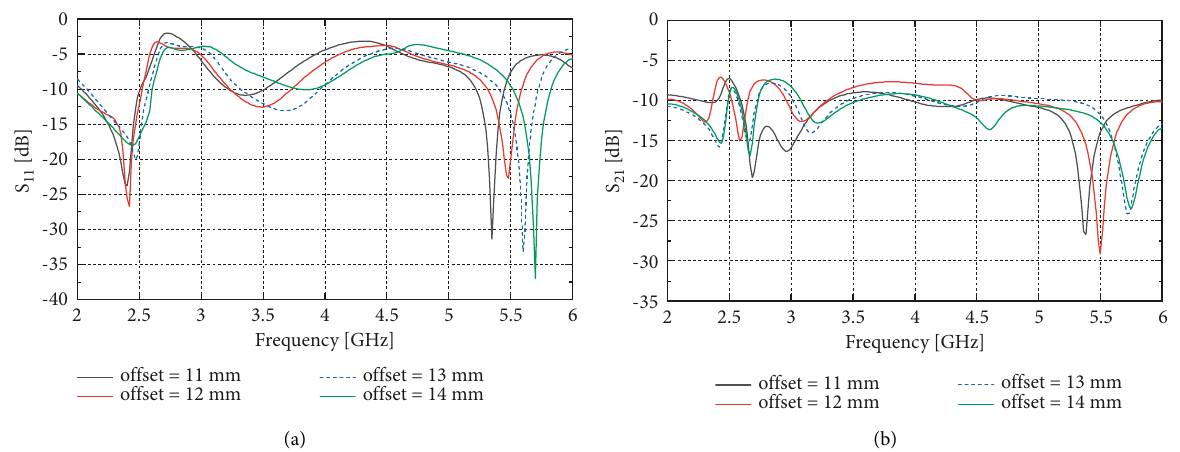
Figure 12: S-parameter of antenna#2 with different offsets of the NL: (a) S